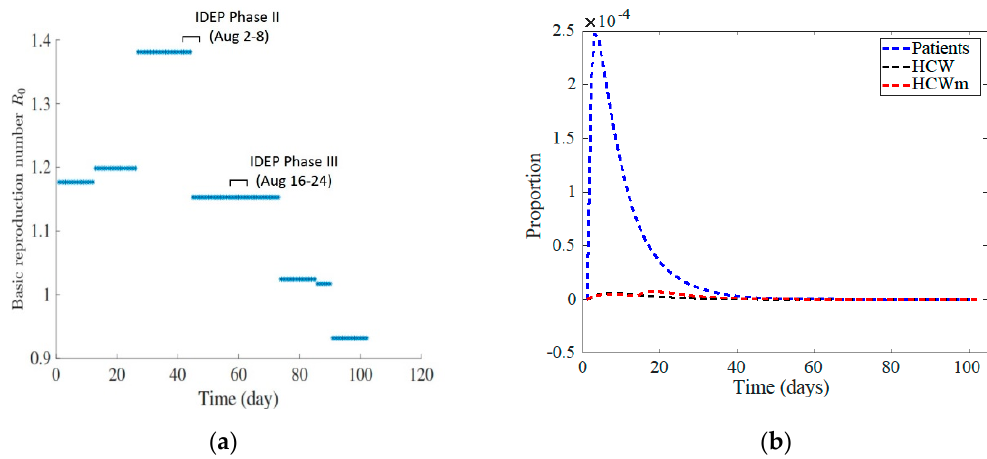
Figure 2. The strength of the outbreak. ( a ) The basic reproduction number R 0 at different times during the King Abdulaziz Medical City (KAMC) outbreak. ( b ) Evolution of proportion of infected patients, HCW, and HCWm for transmission rates at the levels of the last 10 days of the outbreak. The infection disease epidemic plan phase II (infectious disease epidemic plan (IDEP) II activated August 2–8) is on the time period days 43–49 on the time scale and phase III (IDEP III activated August 16–22) is on the time period days 57–63 on the time scale.